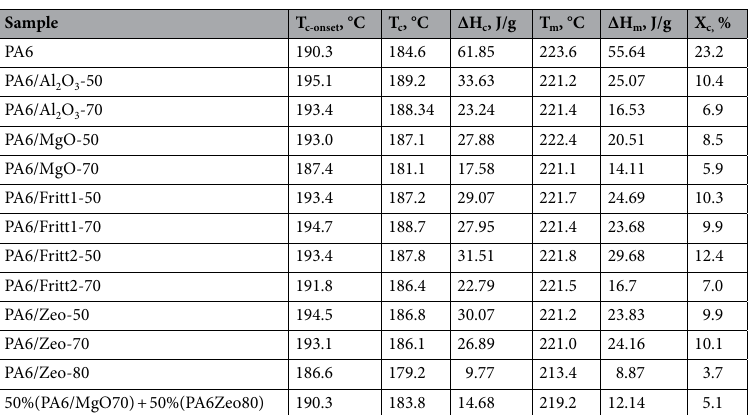
Figure 5. DSC heating ( a ) and cooling ( b ) curves showing the melting and crystallisation behaviours of the representative composite samples as indicated in the graphs.